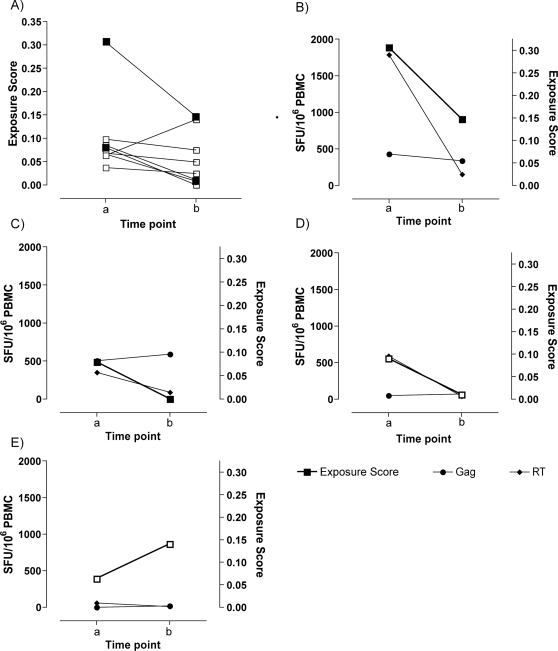
RT responses follow changes in exposure longitudinally.Exposure scores generated from questionnaires at the first time (time point 0) and 1 year later (time point 1) were compared for 7 individuals from the viremic partner group (A). Two individual's partners started anti-retroviral therapy between the time points and their viral loads were below the level of detection at the second time point (filled squares). ELISpot technology was employed to measure IFN-γ responses. Two individuals with aviremic partners at the second time point also showed a decrease in exposure to their partner (B and C), which was reflected in their anti-HIV-1 RT response. This was also seen in a third individual whose exposure dropped dramatically at the second time point (D). One individual showed an increase in their level of exposure, however, there was no responses was above background (<50 SFU) (E).